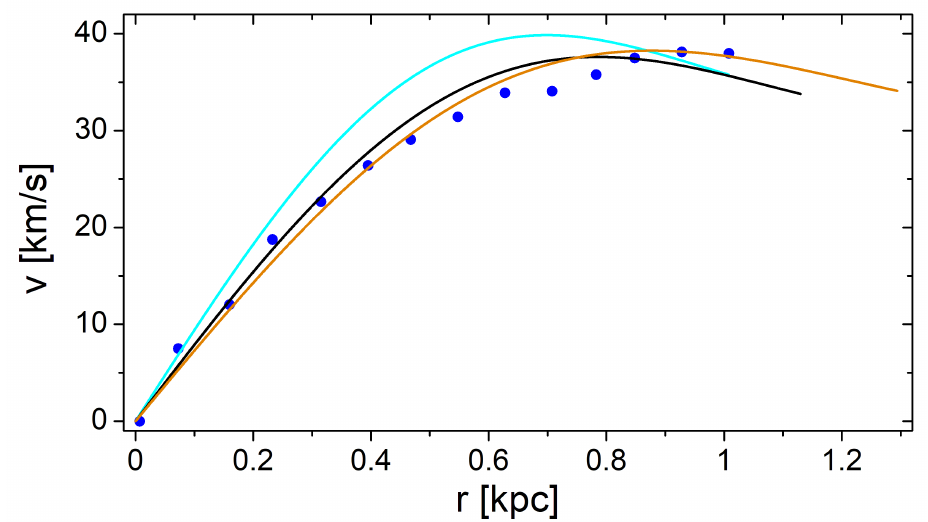
Figure 3. Rotation curves for the dwarf galaxy M81dwB with mass M = 3 × 10 8 M (cid:12) . Blue dots are the observed data for r ≤ 1 kpc. Solid lines are obtained within the model under certain restrictions: ( 1 ) = 3 × 10 8 M (cid:12) and R ( 1 ) = 1 kpc; black line is for M ( 2 ) = 3 × 10 8 M (cid:12) and cyan line is for M BEC BEC ( 3 ) = 3.5 × 10 8 M (cid:12) and R ( 3 ) = 1.3 R ( 2 ) (cid:39) 1.12 kpc; orange line corresponds to M BEC